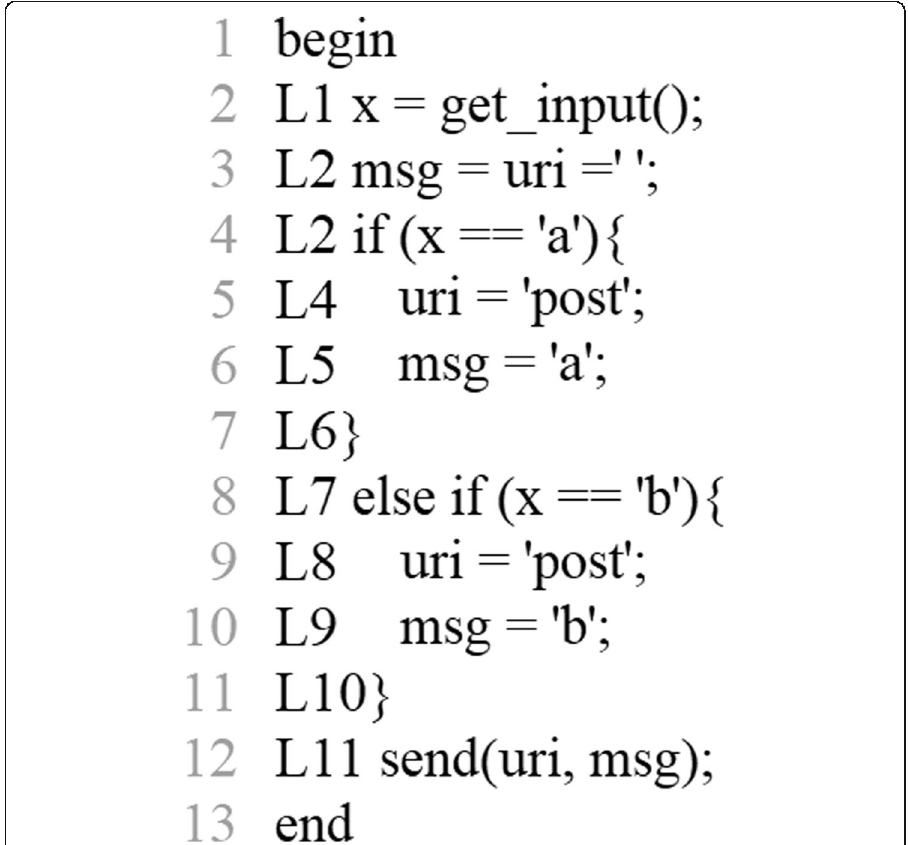
Fig. 3 Example code for dynamic